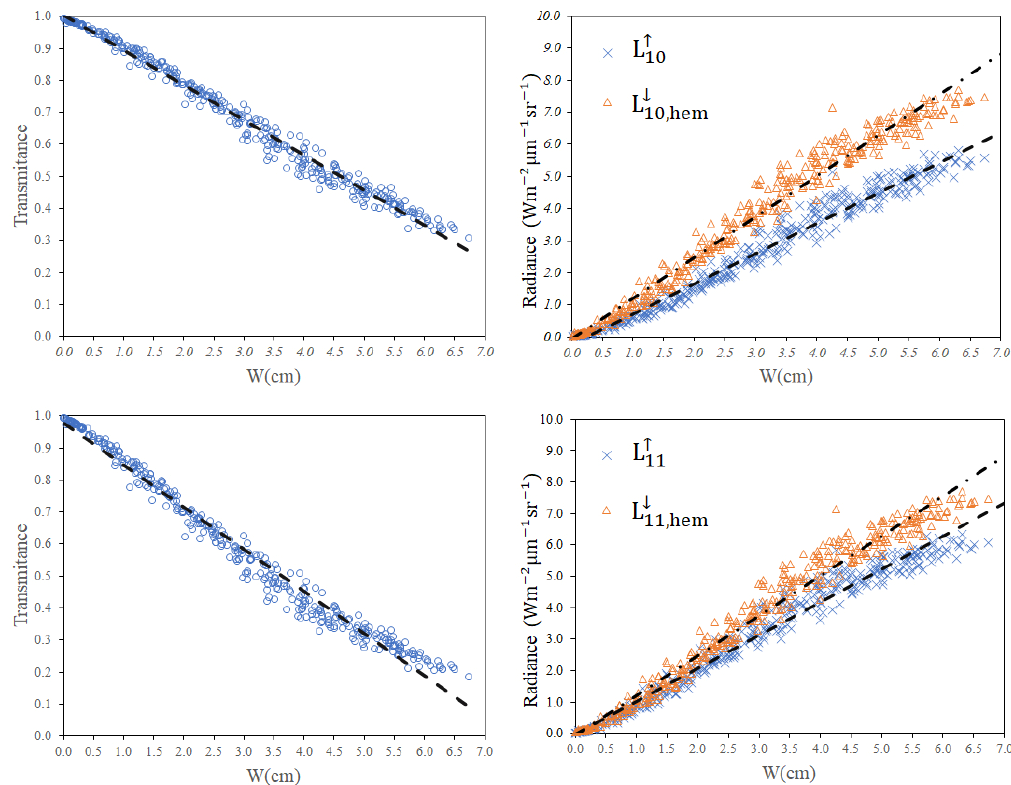
5 of 22 Table 1. Coefficients of the linear regressions between the atmospheric correction parameters and the water vapor content: slope (a), interception (b), and regression coefficient (r 2 ). Sensor/Band Atmospheric parameter